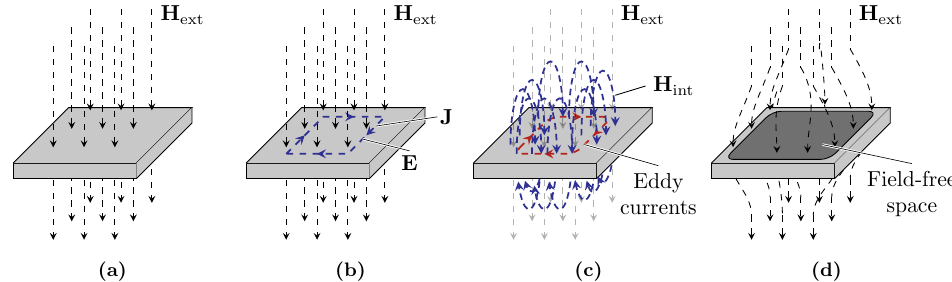
Figure 1. Principle of electrodynamic shielding in quasi-stationary magnetic fields of wireless power transfer systems according to [14]: ( a ) penetration of an external alternating magnetic field H ext in an = 0, ( b ) induction of an alternating electrical field E , ( c ) eddy electrically conductive material with σ e (cid:54) current induction, ( d ) distribution of the resulting magnetic field H ext as a result of the internal counterfield H int